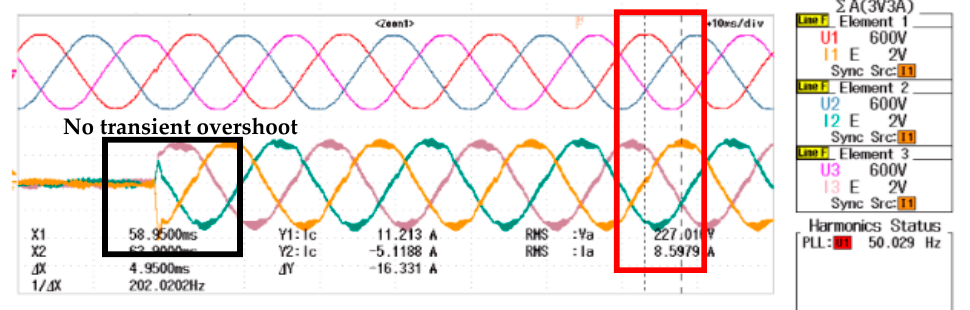
Figure 22. Injection of reactive power when step change has been applied from 0 to 6 kVar (0.6 p.u).